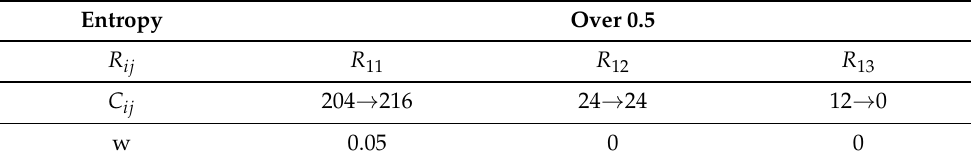
Table 3. Entropy